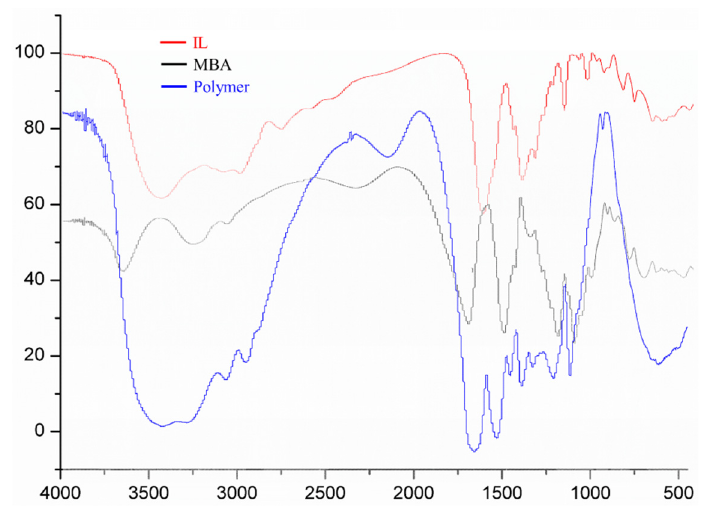
Figure 1. The IR spectrum of IL, MBA and